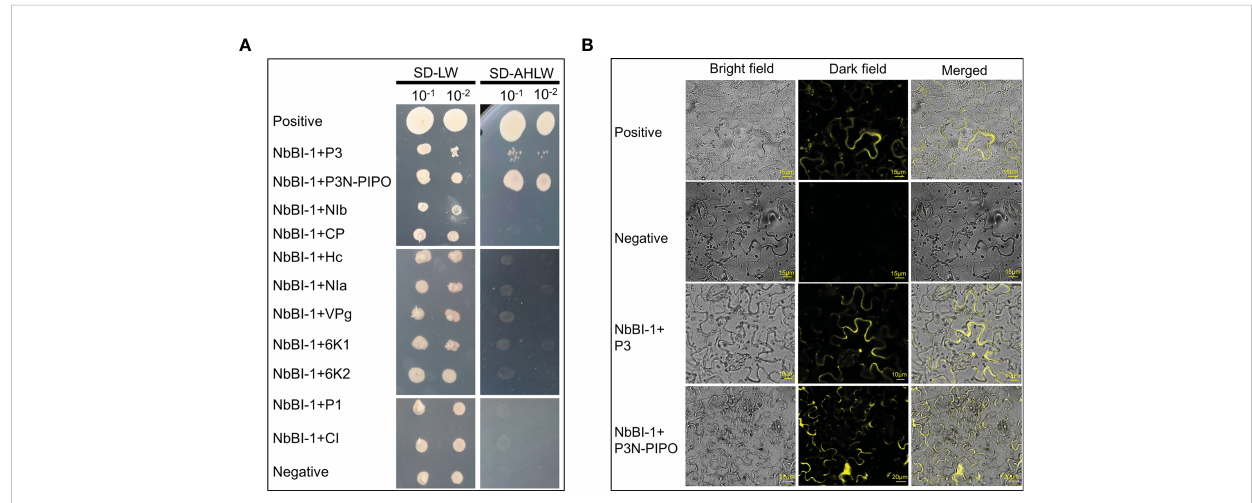
FIGURE 1 Interaction of NbBI-1 with PVY-encoded proteins (A) NbBI-1 interaction with PVY-encoded P3N-PIPO and P3 by Y2H. Negative: pTSU2-APP+pPR3- N. Positive: pTSu2-APP+pNubG-Fe65. (B) NbBI-1 interactions with P3 and P3N-PIPO by BiFC. Negative: N-YFP+C-YFP. Positive: N-YFP-TuMV-P3N-